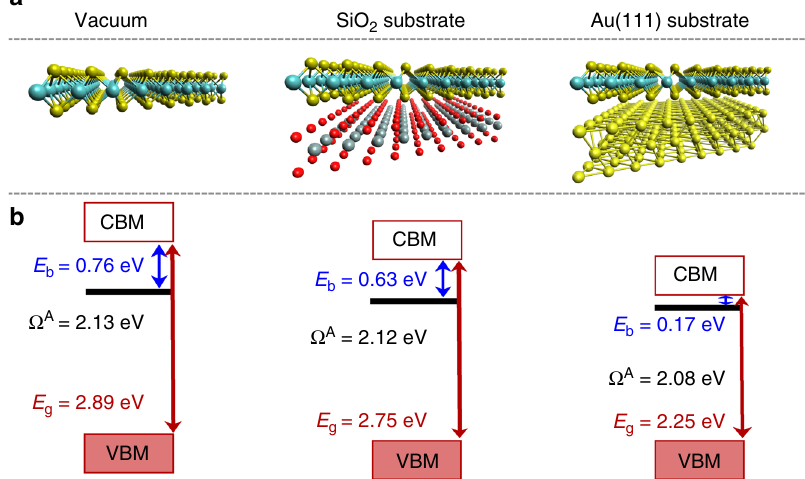
Fig. 4 Energy composition of the A exciton on various substrates. We consider vacuum, an SiO 2 and an Au(111) substrate at a distance of 3 Å (see a ). For each system the bandgap E g , the excitation energy Ω A and the binding energy E b are given in